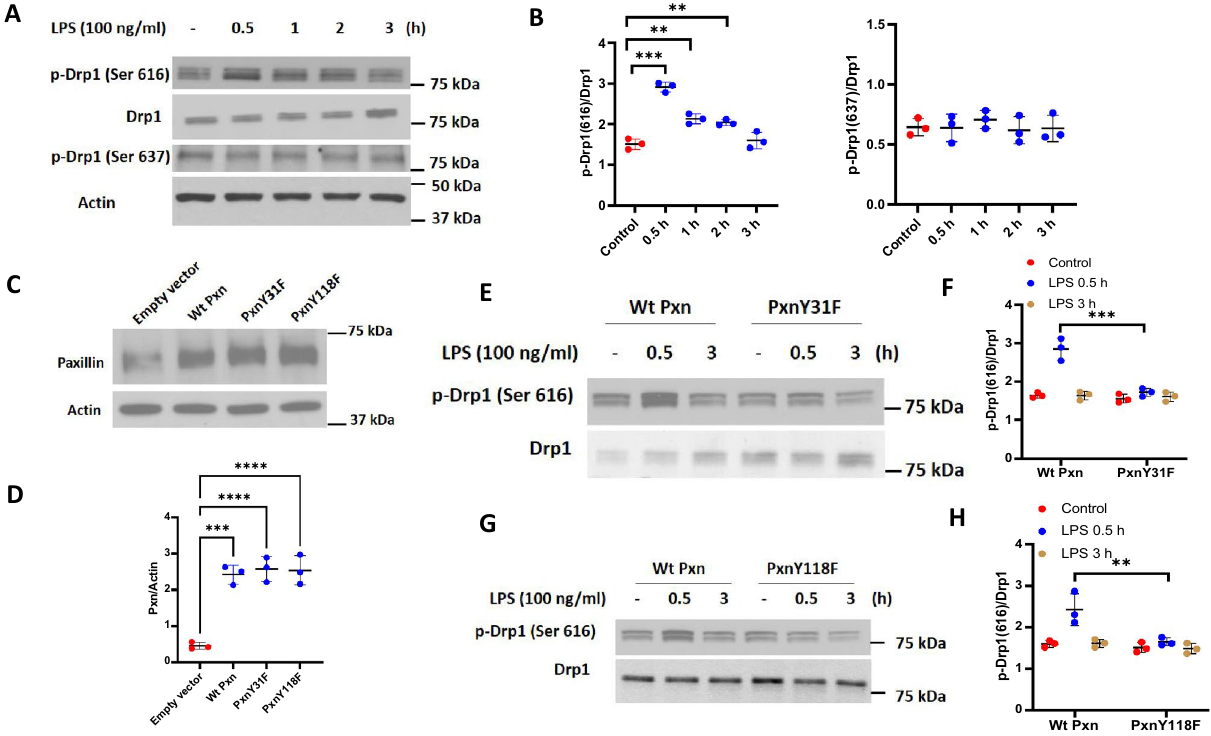
Figure 4. LPS-induced DRP1 phosphorylation requires both paxillin and ERK1/2. ( A ) HLMVECs were treated with LPS (100 ng/ml) for the indicated periods, phosphorylation of DRP1 at Ser616 and Ser637 was analyzed by Western blot. Equal protein loading was verified by probing with total actin and DRP1. ( B ) Results of quantitative analysis of ( A ) are shown as ratio of phosphorylated DRP1 to total DRP1. Values are means ± SD of 3 independent experiments. **p < 0.01, ***p < 0.005, compared with control. ( C ) HLMVECs were transfected with wild type paxillin, mutant paxillinY31F plasmid or mutant paxillinY118F. After 48 h of transfection, cells were lysed in cell lysis buffer, and cell lysates (20 µg protein) were subjected to SDS-PAGE and Western blotting with anti-paxillin antibody. Shown is a representative blot of three independent experiments. ( D ) The paxillin bands in ( C ) were quantified by image analysis. ***p < 0.005, compared to control cells transfected with empty plasmid backbone. ****p < 0.001, compared to control cells transfected with empty plasmid backbone. ( E , G ) HLMVECs were transfected with wild type paxillin, mutant paxillinY31F plasmid or mutant paxillinY118F. After 48 h of transfection, cells were treated with vehicle or LPS (100 ng/ml) for 0.5 and 3 h. Cell lysates (20 µgs protein) were subjected to SDS-PAGE and Western blotting with phospho-Ser616 DRP1 and anti-DRP1 antibodies. Shown is a representative blot of three independent experiments. ( F , H ) Results of quantitative analysis are shown as intensity ratio of phosphorylated DRP1 to total DRP1. Values are means ± SD of 3 independent experiments. ***p < 0.005, LPS 0.5 h wild type paxillin versus LPS 0.5 h mutant paxillinY31F. **p < 0.01, LPS 0.5 h wild type paxillin versus LPS 0.5 h mutant